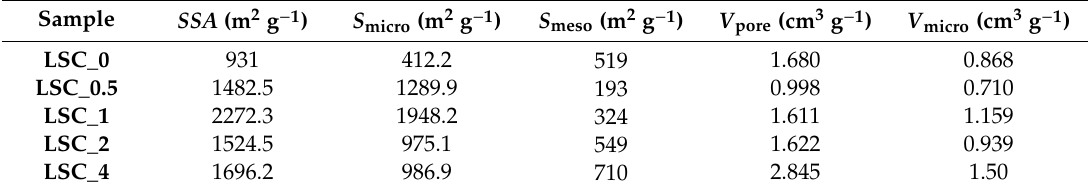
Table 1. Porosity properties of the Lapsi seed-derived nanoporous carbon